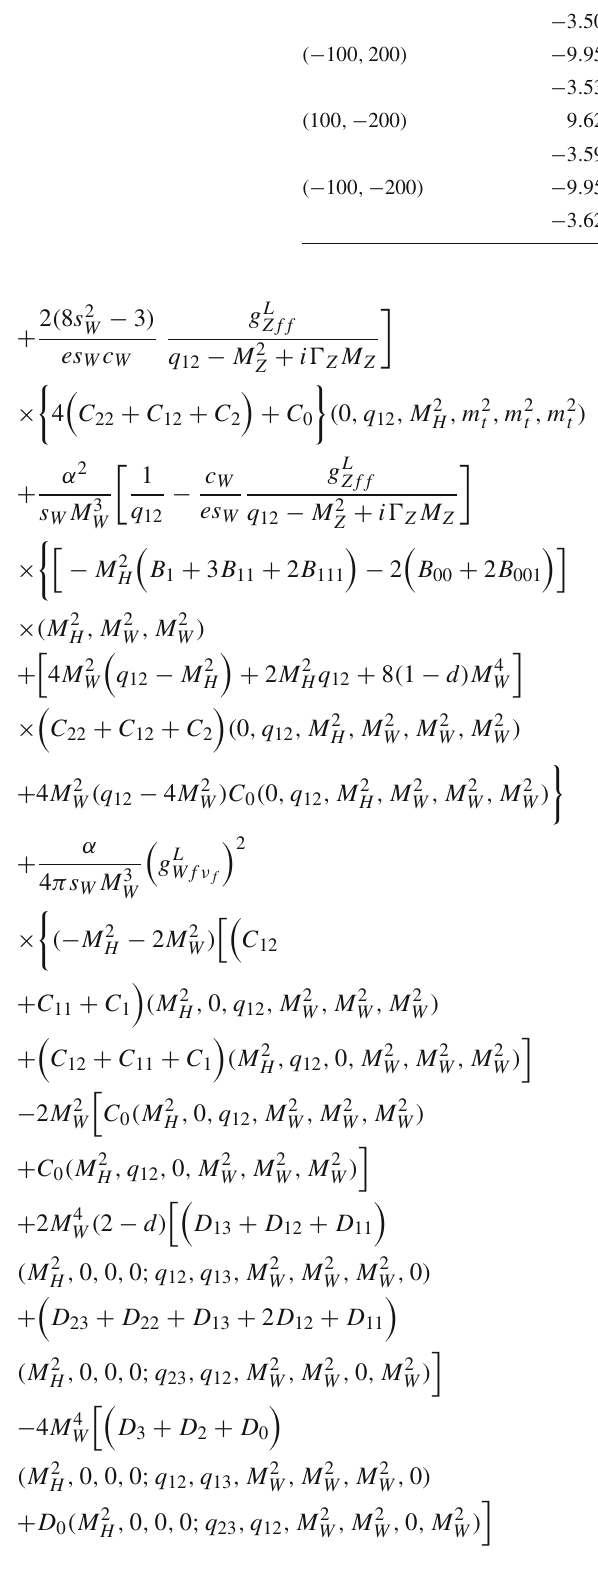
Table 2 Numerical checks for form factor F 2 L in this work with b 1 in A 2 of [20]